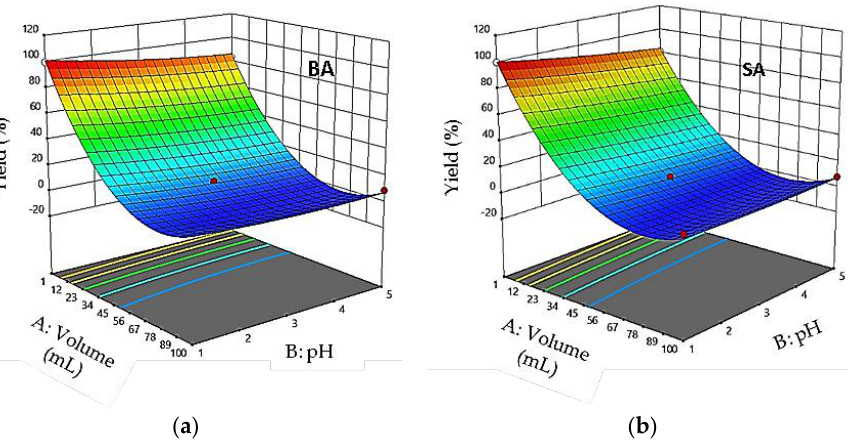
Figure 3. Response surface plots showing the effect of the sample volume and pH on percolation efficiency: flow rate = 4.5 mL min −1 . ( a ) 𝑹 𝒓𝑩𝑨 ; ( b ) 𝑹 𝒓𝑺𝑨 .